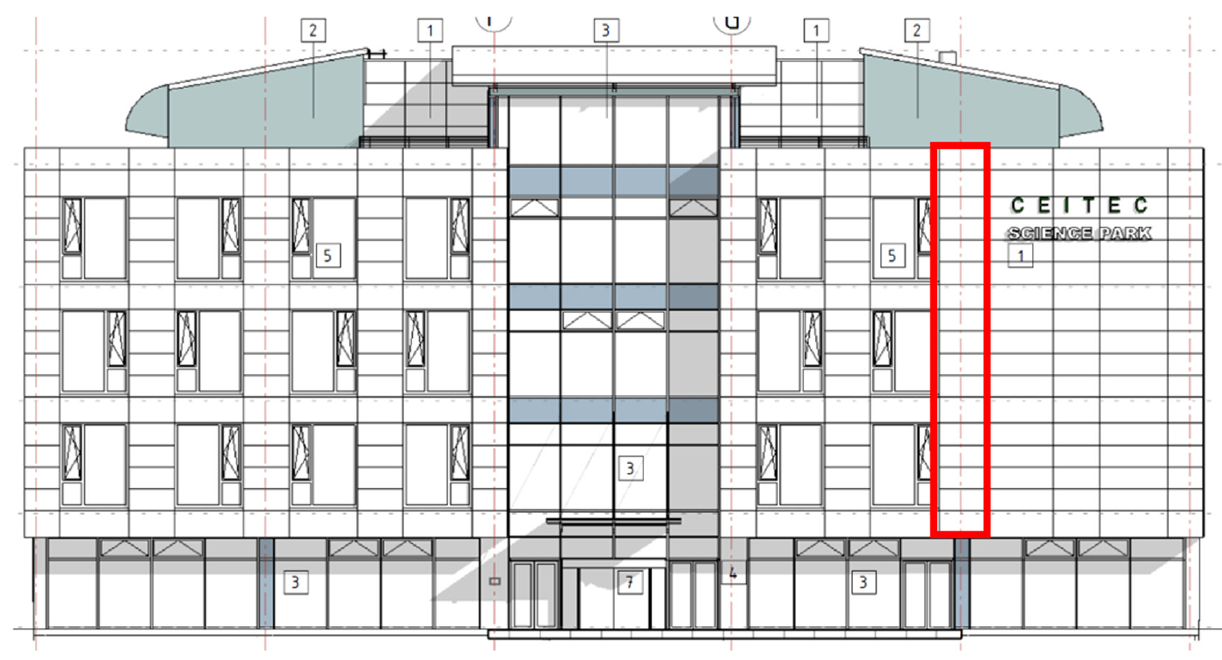
Figure 1. Measured and numerically evaluated faade. Façade part in question is marked red, façade height as well as air gap is approx. 13.7 m.